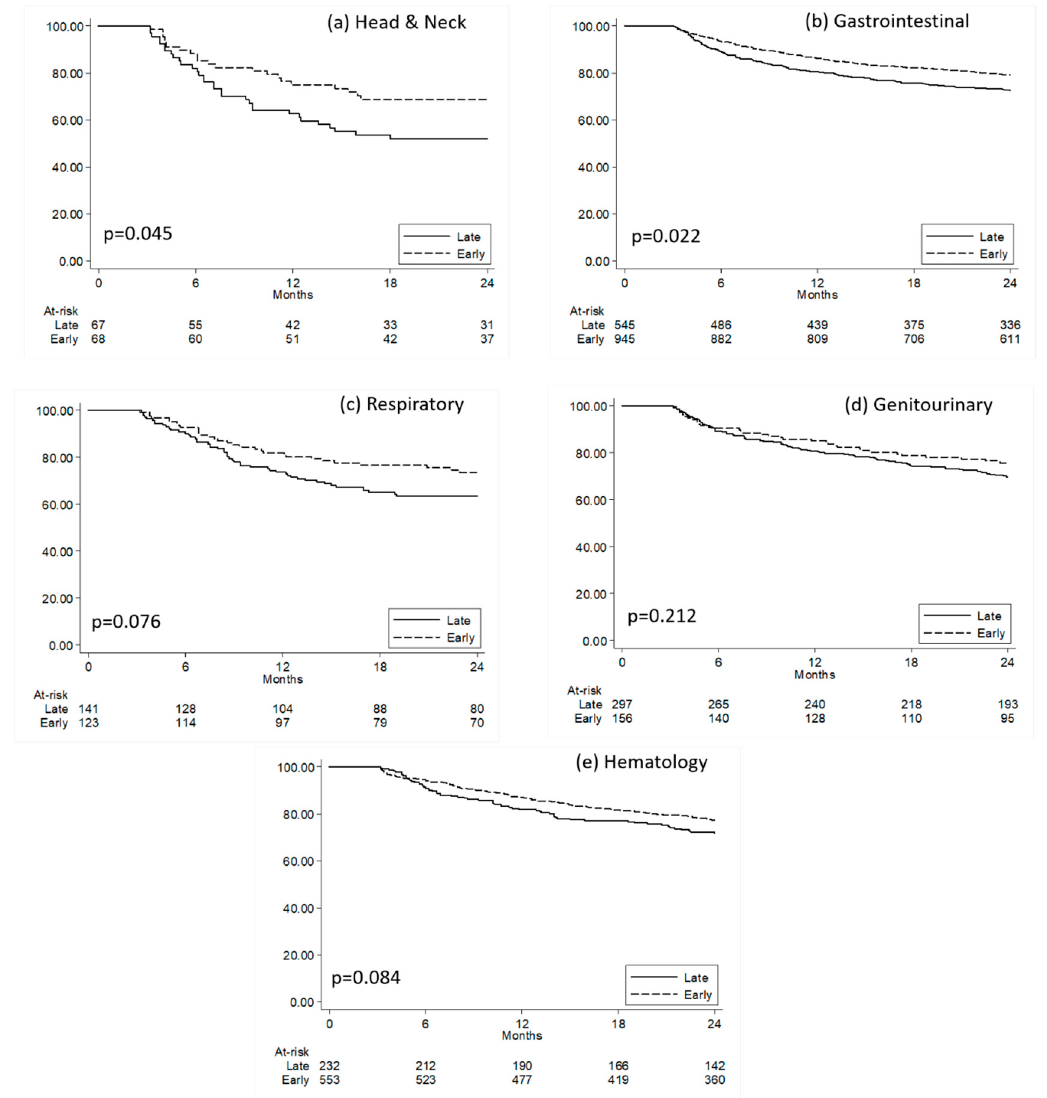
Figure 3. Kaplan–Meier curves comparing survival time since cancer diagnosis for non-metastatic patients with early versus late clinical nutrition. ( a ) Head and Neck; ( b ) Gastrointestinal, ( c ) Respiratory, ( d ) Genitourinary, ( e ) Hematology. Quartiles of time (months) since cancer diagnosis to the first clinical nutrition prescription was calculated in all non-metastatic patients receiving clinical nutrition; patients were then classified as having early or late administration when presenting a time since diagnosis to clinical nutrition administration below or above the first quartile, respectively. P: p -values from Log-Rank Tests.